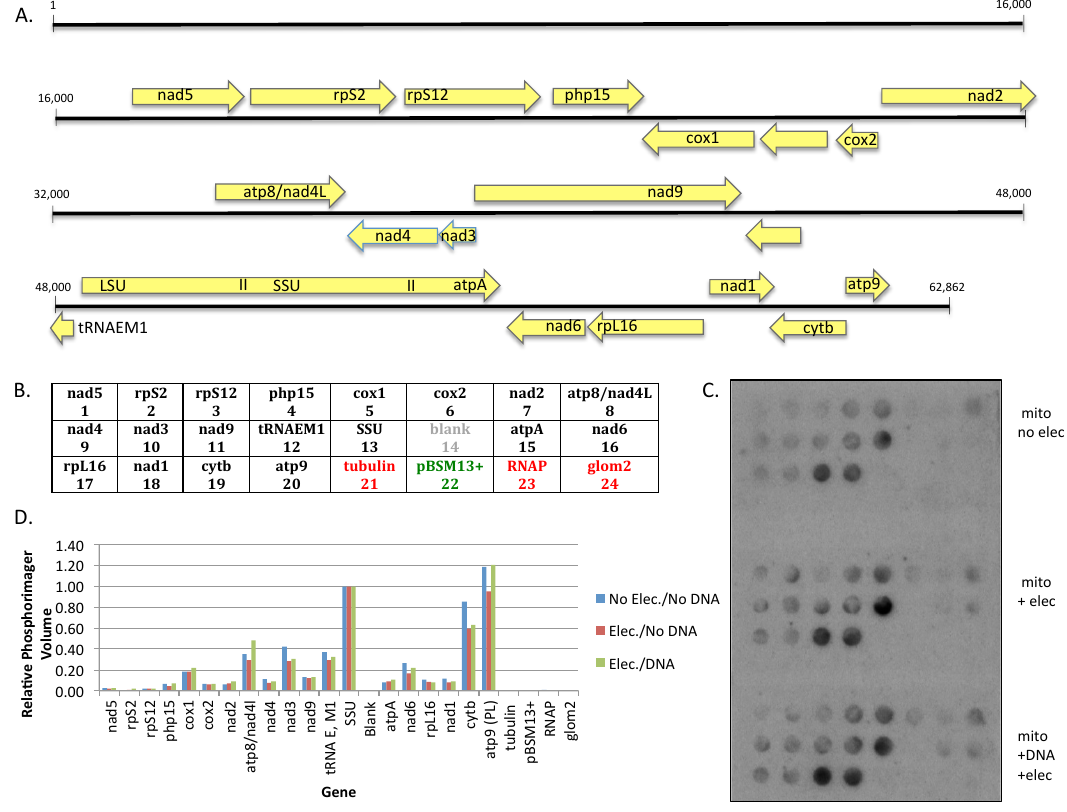
Figure 3. Transcription of endogenous genes is not altered by electroporation: ( A ) Transcript map of the genes probed in dot blot experiments using gene designations from [7]. ( B ) Grid positions of immobilized PCR fragments; ( C ) Dot blots probed with labeled RNA synthesized by: mitochondria before electroporation ( top ); mitochondria after electroporation in the absence of exogenous DNA ( middle ); and mitochondria after electroporation in the presence of exogenous DNA ( bottom ). ( D ) Quantification of the data in ( C ) showing relative expression levels of individual genes under each of the three